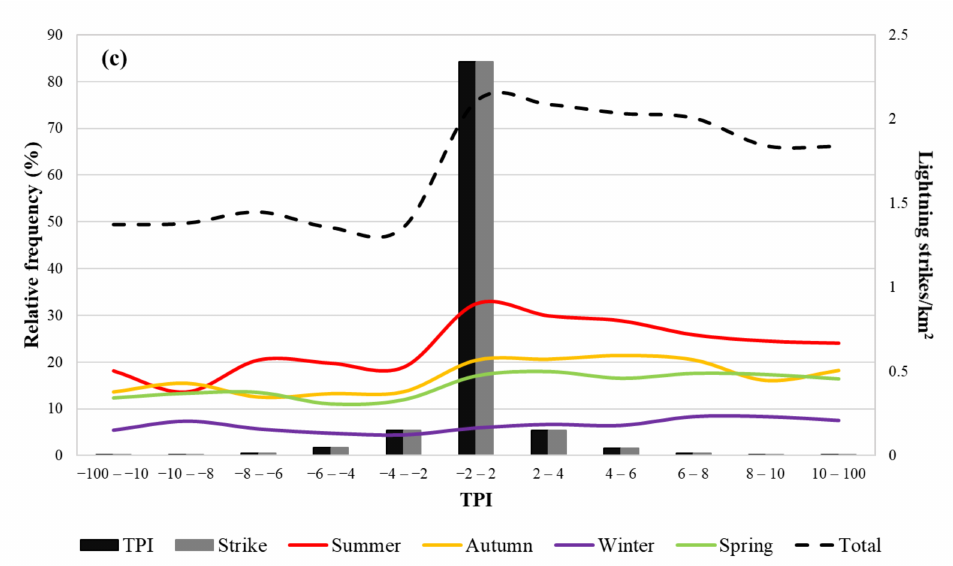
Figure 7. Density of total and seasonal cloud-to-ground (CG) lightning strikes as colored lines (right axis) divided into ( a ) elevation, ( b ) aspect, and ( c ) TPI. Relative frequency (%) of lightning strikes (left axis) and land–surface as a function of elevation, aspect and TPI (horizontal axis). Black bars indicate the proportion of the total land area that falls within each classification. Grey bars indicate the relative frequency of lightning strikes within each classification.